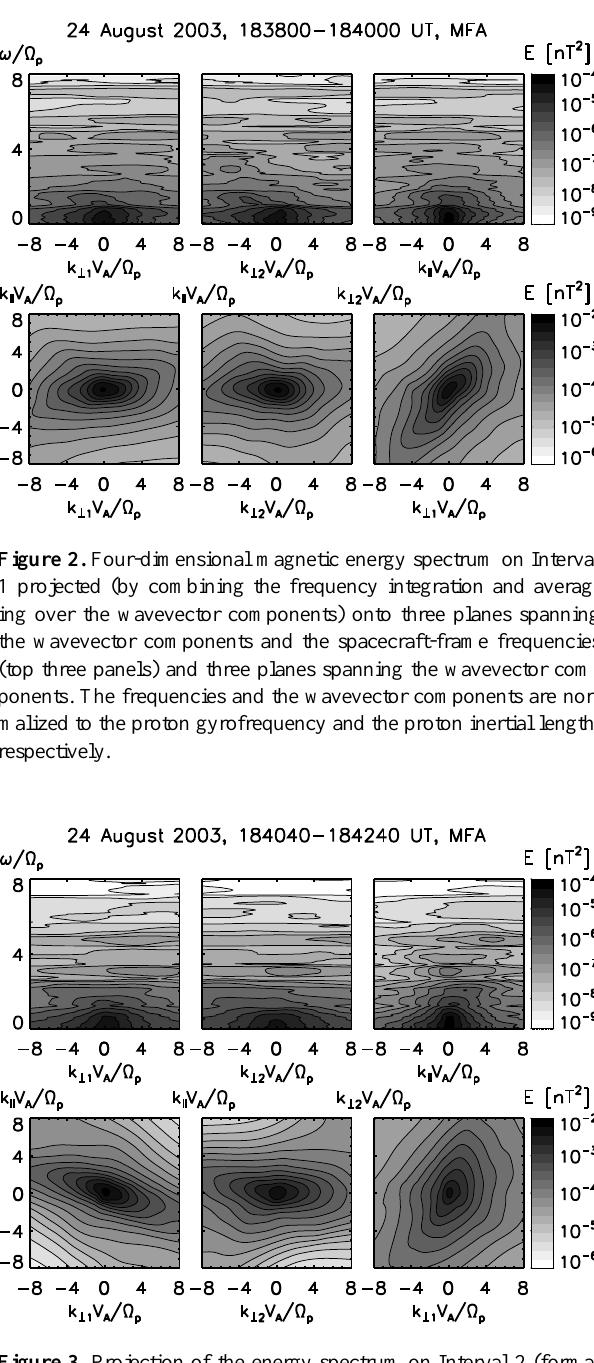
Figure 3. Projection of the energy spectrum on Interval 2 (format of panels the same as in Fig. 2).